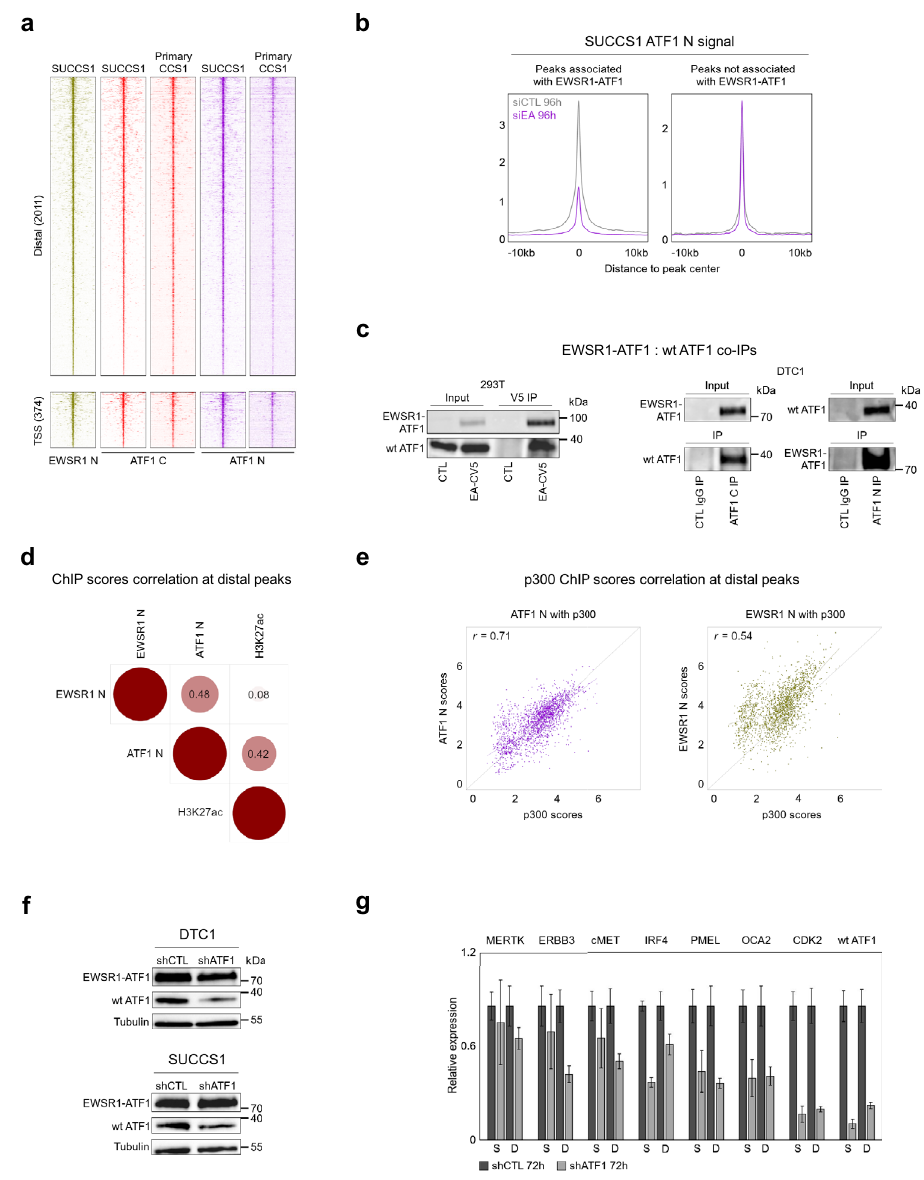
Fig. 3 wt ATF1 is present at a majority of EWSR1-ATF1 binding sites. a Heatmaps depicting EWSR1 N, ATF1 C and ATF1 N ChIP-seq signal intensities at 2011 distal and 374 proximal EWSR1-ATF1 binding sites in SU-CCS-1 and primary CCS1 tumor cells, illustrating genomic co-occupancy by the wt ATF1 TF at the fusion protein binding sites. For each heatmap 20 kb regions centered on the EWSR1-ATF1 peaks are shown. Signals are ranked by ATF1 C intensity. b Composite plots showing changes in ChIP-seq signal for ATF1 N peaks associated ( left ) or not ( right ) with EWSR1-ATF1 binding in SU-CCS-1 cells transfected with a siRNA targeting the fusion gene (siEA) or control (siCTL) siRNAs. The loss of the fusion protein is associated with a decrease in ATF1 N signal only at EWSR1-ATF1 bound sites, suggesting wt ATF1 recruitment by the fusion protein. c Co-immunoprecipitation (Co-IP) assay showing the direct interaction between the EWSR1-ATF1 and wt ATF1 proteins in 293 T ( left ) and DTC1 cells ( right ). 293 T cells were transfected with either a V5-tagged EWSR1-ATF1 (EA-CV5) or empty vector (CTL) constructs. The IP was performed using an anti-V5 tag antibody, and the western blot revealed using anti- V5 ( top ) or anti-ATF1 C ( bottom ) antibodies. DTC1 IPs were performed using anti-ATF1 C or -ATF1 N antibodies, compared to control (CTL) IgG, and the western blot revealed using an anti-ATF1 C antibody. The experiment was independently repeated twice with similar results. d Correlation plot of EWSR1 N, ATF1 N, and H3K27ac ChIP-seq scores at the 2011 distal regions, showing stronger correlation between H3K27ac deposition and wt ATF1 presence, than with EWSR1-ATF1 presence (represented by ATF1 N and EWSR1 N signals, respectively). e Scatter plots of ATF1 N and p300 ( left ), or EWSR1 N and p300 ( right ) ChIP-seq scores, illustrating that wt ATF1 presence correlates better with p300 occupancy than EWSR1-ATF1. f Western blot analysis of EWSR1- ATF1 and wt ATF1 protein levels in DTC1 and SU-CCS-1 cell lines infected with a shRNA targeting the wt ATF1 transcript (shATF1) or an unrelated sequence (shCTL) at 72 h post-lentiviral infection. Tubulin protein levels were used as loading control. The experiment was independently repeated twice with similar results. g qPCR analysis showing reduction of wt ATF1 transcripts, as well as a panel of EWSR1-ATF1 / wt ATF1 co-regulated target transcripts, in shATF1- vs shCTL-infected SU-CCS-1 (S) and DTC1 (D) cells at 72 h post-lentiviral infection. Three replicates of each condition were used to calculate mean Ct values, mean relative expression values were then calculated according to the 2 - ΔΔ Ct method relative to the shCTL sample values, and normalized to the endogenous control gene GAPDH . Error bars show standard deviation of mean values ( n = 3 sample replicates). The experiment was independently repeated twice with similar results. Source data are provided in the Source Data fi